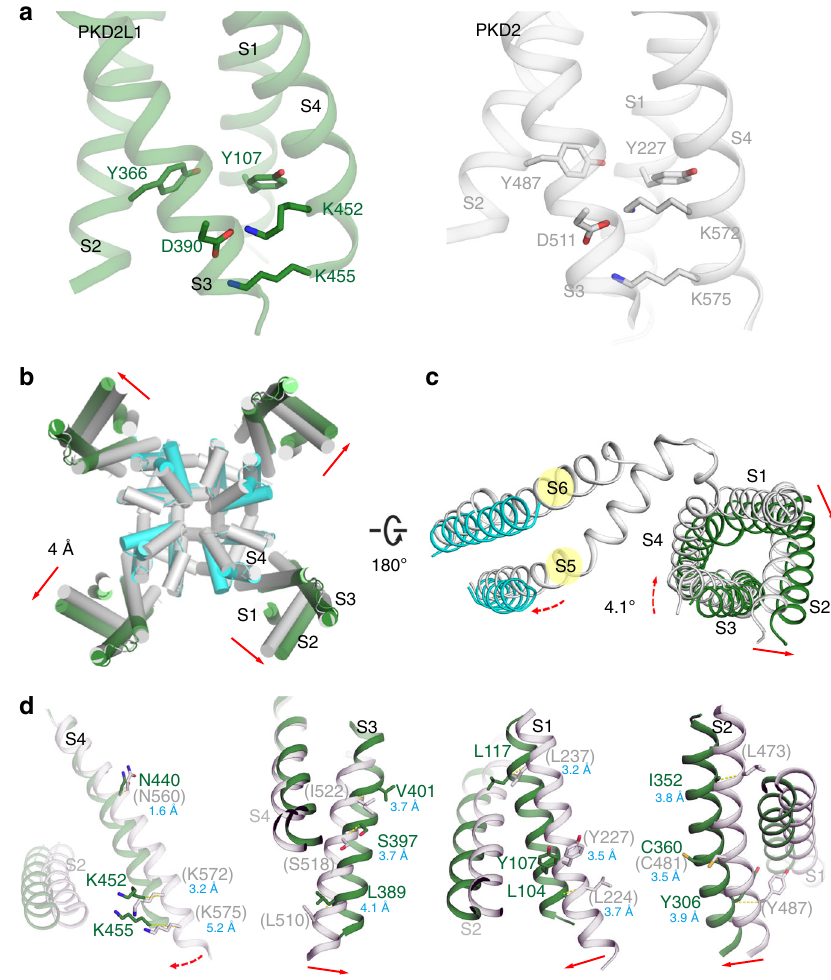
Fig. 3 Conformational changes of the VSDs modeled in PKD2L1. a PKD2L1 (green) and PKD2 (gray) both harbor two lysines, K452 and K455 (resp. K572 and K575 in PKD2) in S4, which increases their voltage sensitivity. The two lysines are potentially stabilized by D390 from S3, Y107 from S1, and Y366 from S2 (resp. D511, Y227, and Y487 in PKD2). b Cytosolic view of structural comparison of PKD2L1 (colored as in Fig. 1) and its homologous closed-state model, excluding polycystin domains for the ease of visualization. The whole structure of PKD2L1 displays a clockwise rotation relative to its closed state as viewed from the intracellular side. The red full arrows indicate overall shifts of each protomer from the closed to open state. c One protomer from panel b viewed from the extracellular side; only six transmembrane helices of this protomer are shown. The red dotted arrows indicate the rotation of speci fi c regions. d Dissection of the conformational shifts of the VSD segments relative to the pore domain. The open-state cryo-EM PKD2L1 structure and the closed-state PKD2L1 model are superimposed overall. Adjacent helices are shown in each panel as the reference to indicate the orientation of the structures. The respective residue names and numbers in PKD2 are shown in gray within parentheses throughout this study when